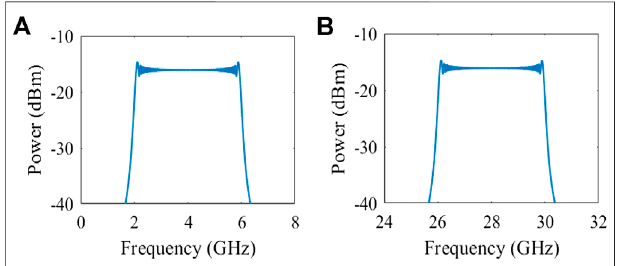
FIGURE 7 | Spectra of original linearly-chirped signals with center frequencies of (A) 4 GHz and (B) 28